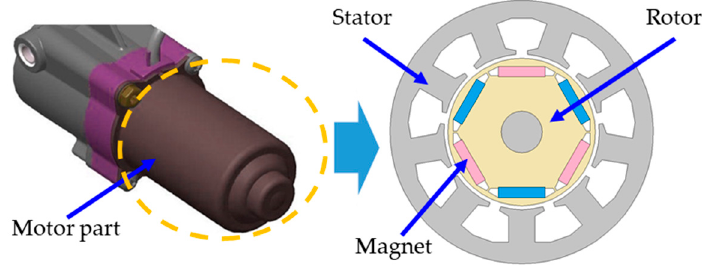
Figure 3. Shape of conventional brushless DC (BLDC) motor for an EOP. Table 1. Specifications of the conventional BLDC motor.